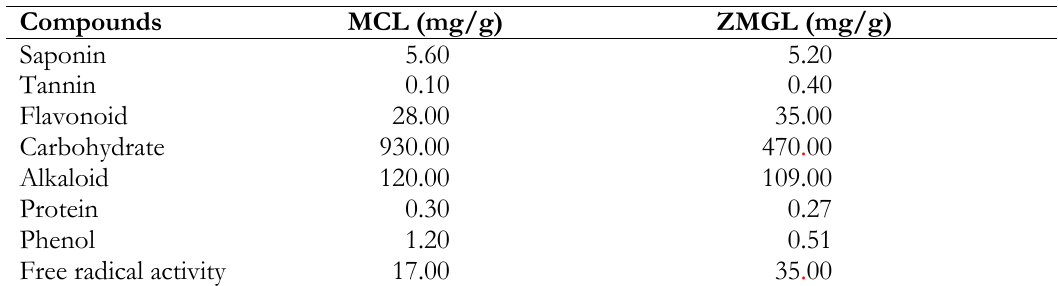
Table III. Quantity of phytochemical compounds in the extracts of two lines of G. sylvestre